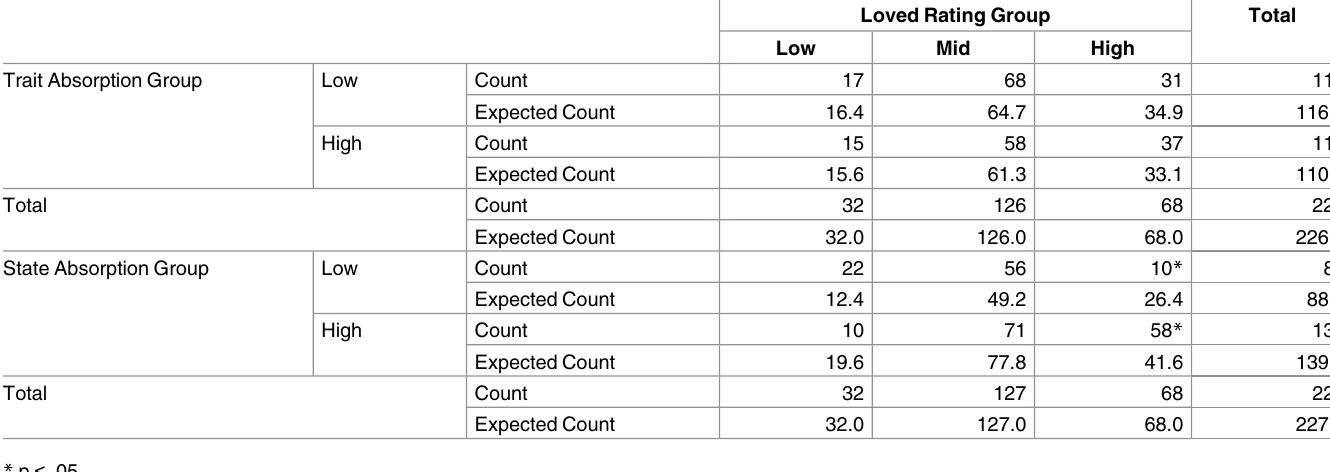
Table 3. The association of trait and state absorption with loved rating